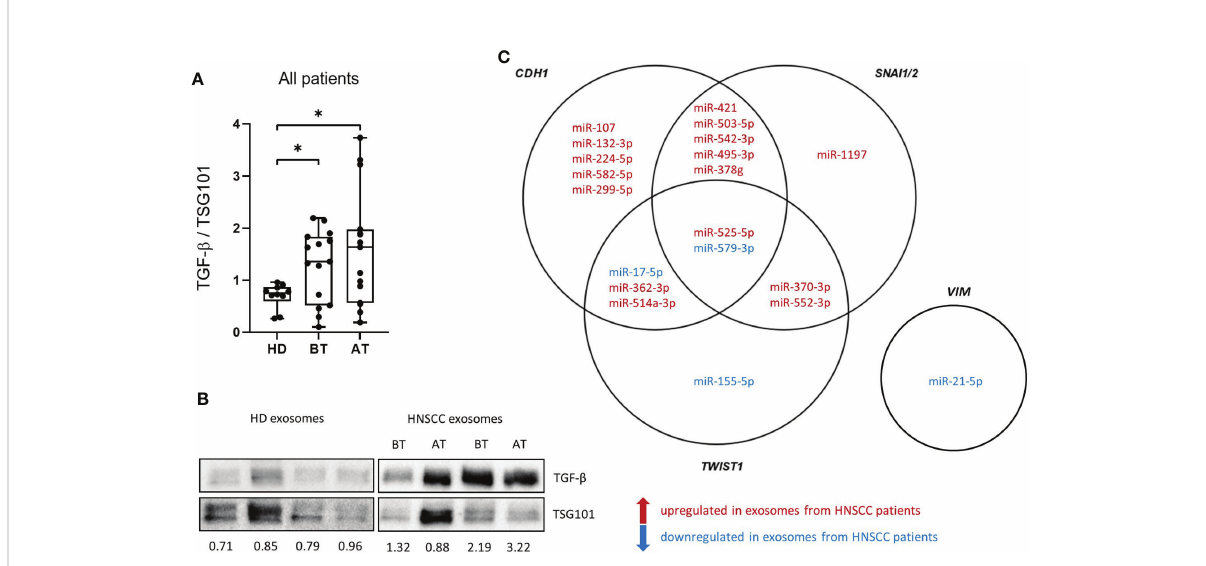
FIGURE 4 Transforming growth factor ß (TGF-ß) levels and miRNA cargo of exosomes isolated from plasma of HNSCC patients. (A) TGF-ß levels of exosome isolated from plasma of n = 10 HD and n = 15 HNSCC patients BT and AT were measured by western blot and normalized to the exosomal marker protein TSG101. Results are plotted as box-and-whisker blots representing the median value, the 25th and 75th quartiles and the range. Mann-Whitney test was applied to compare HD with each BT or AT. * corresponds to p ≤ 0.05. (B) Representative western blot images of exosomes analyzed for TGF- b and TSG101. Numbers below blots indicate relative exosomal TGF- b intensity normalized to TSG101. (C) Venn diagram of exosomal miRNAs targeting CDH1 , VIM , TWIST1 and SNAI1/2 . miRNAs in red are upregulated in exosomes from HNSCC patients compared to exosomes from HD and miRNAs in blue are downregulated in HNSCC compared to HD